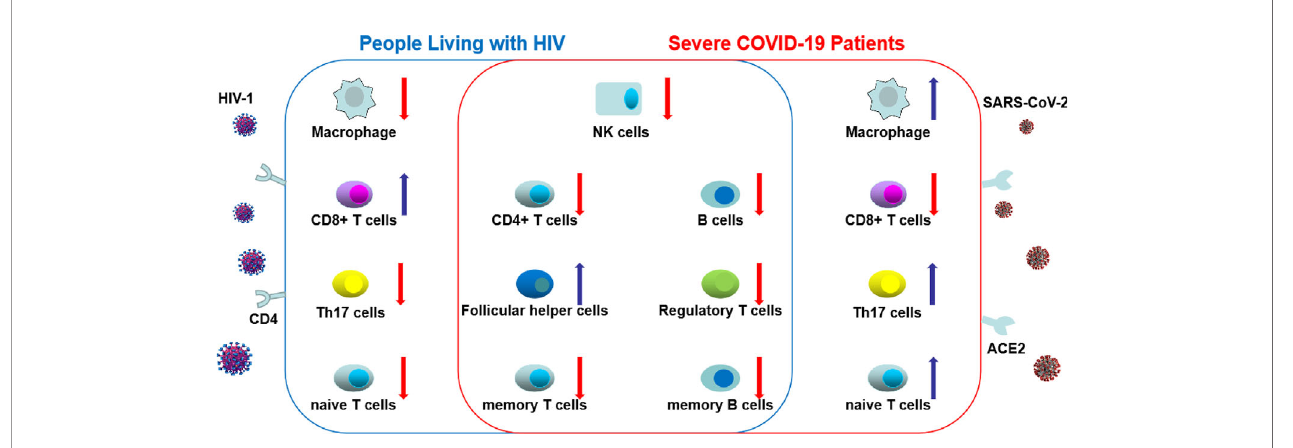
FIGURE 2 | The changes of different peripheral blood cell types in HIV and severe coronavirus disease-19 (COVID-19). In COVID-19 and HIV infection, total count of natural killer cells, B cells, CD4+ T cells, regulatory T cells, memory T and B cells decrease, whereas the count of follicular helper cells increase. These common changes between HIV and COVID-19 were shown in the central circle. However, distinct changes were shown in total count of macrophage, CD8+ T cells, Th17 cells and naive T cells between people living with HIV (PLWH) and severe COVID-19. (The red arrow indicates a decrease in the number of cells; the blue arrow indicates an increase in the number of cells).